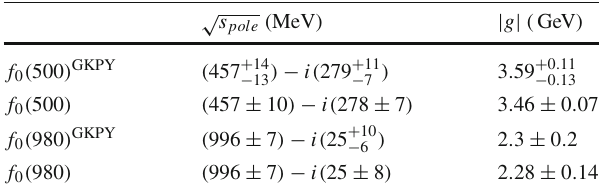
Table 5 Pole positions and ππ couplings of both f 0 ( 500 ) and f 0 ( 980 ) resonances from our global parameterization. Almost indistinguishable values would be obtained for solutions I, II and III. Note that they are very compatible with the GKPY dispersive results in [36] √